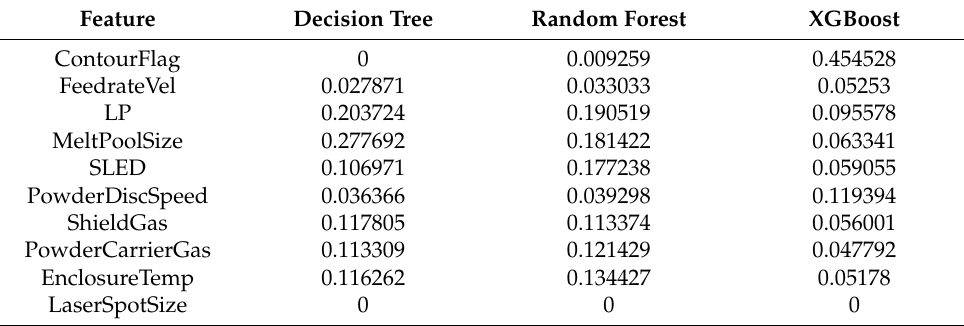
Table 3. Comparison of feature selection